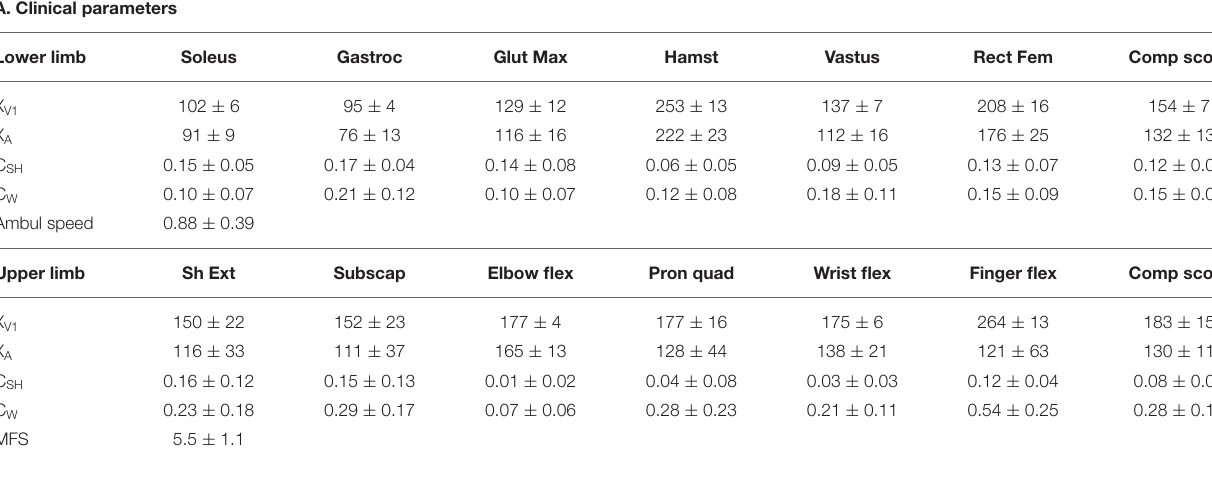
TABLE 1 | Clinical parameters and comparison of muscle